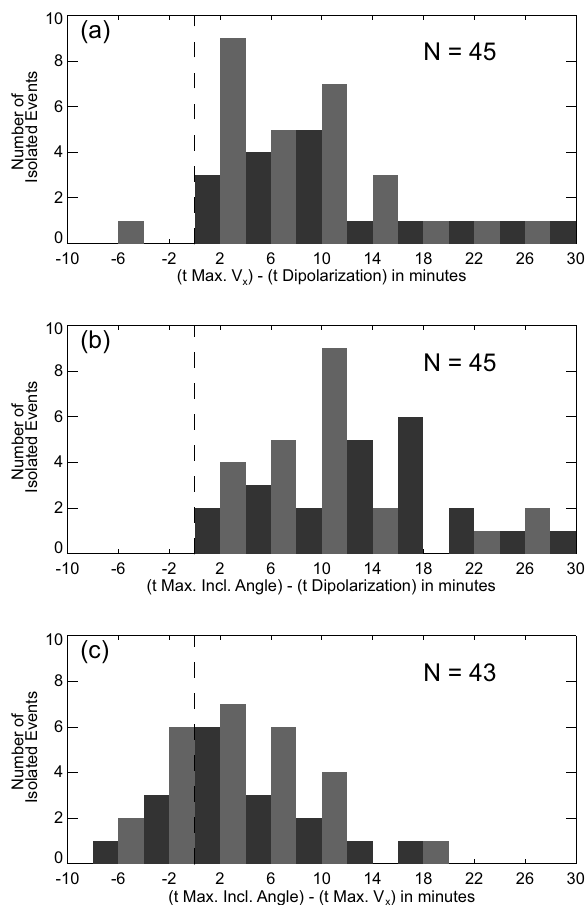
Fig. 9. ( a ) A histogram of the number of isolated events in 2min bins of the difference between the time when the maximum earth- ward flow velocity was observed and the start of the magnetic field dipolarization. ( b ) The number of events in 2min bins of the dif- ference between the time when the maximum inclination angle was observed and the start time of the dipolarization. ( c ) The number of events in 2min bins of the difference between the time when the maximum inclination angle was observed and the time when the maximum earthward flow velocity was